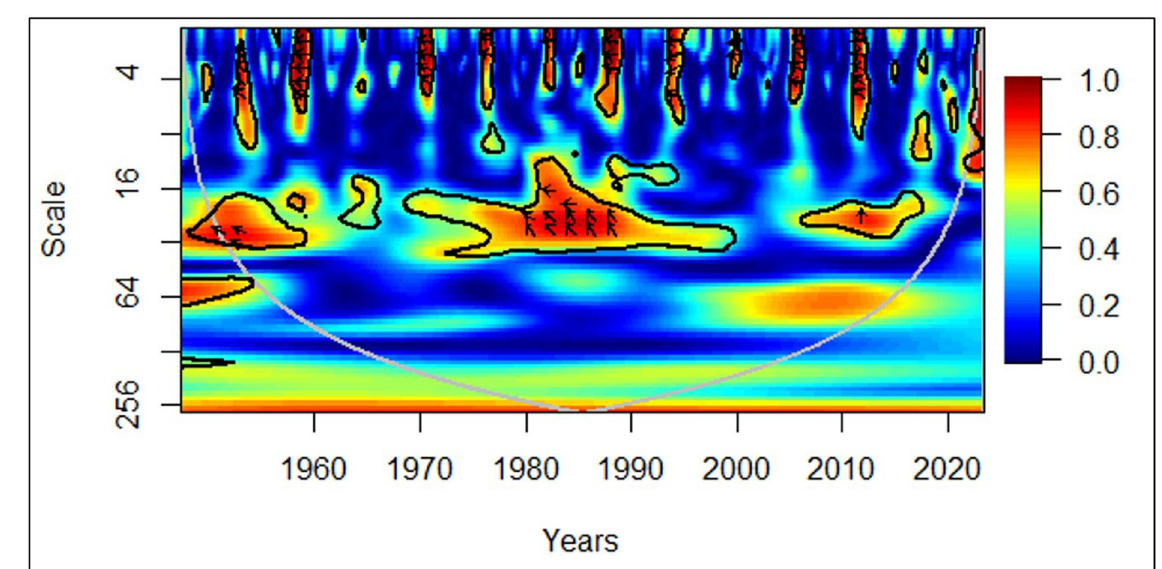
Fig 10. South American region: GDP vs EPOP. Source: Authors’ illustration.